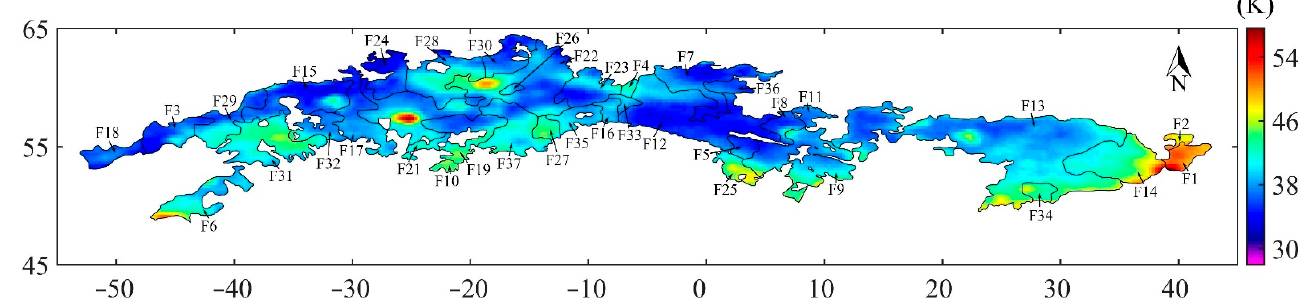
Figure 10. TB difference map of Mare Frigoris at 37 GHz (equidistant cylindrical projection). The black lines are the geologic boundaries determined by Hiesinger et al. [10].